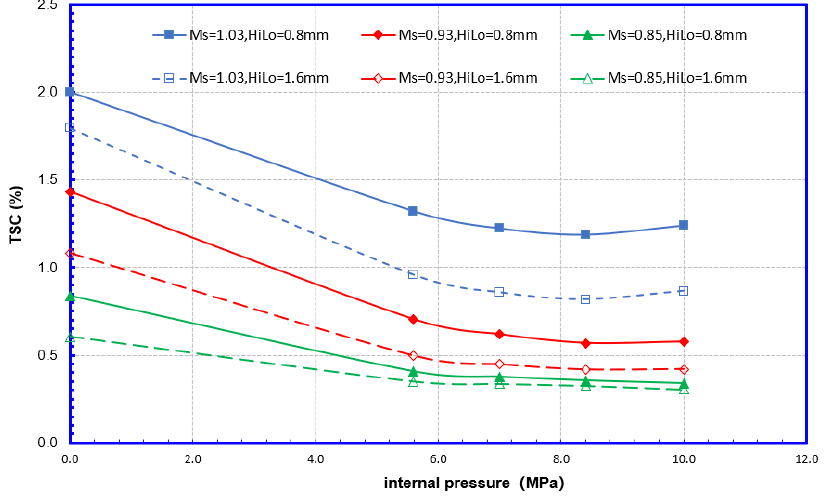
Figure 13. Misalignment and mismatch effects on TSC 12.8 mm — 12.8 mm WT.